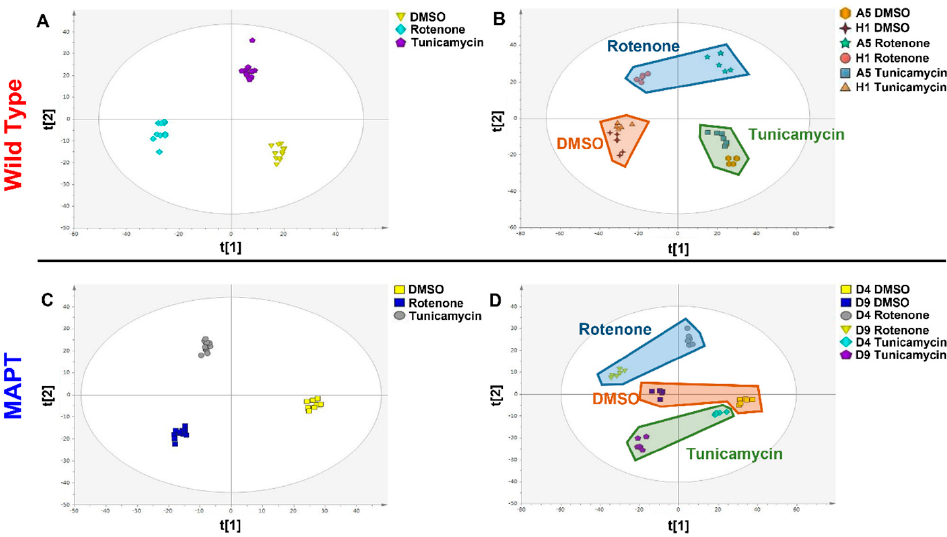
Figure 1. Multivariate partial least squares − discriminant analysis (PLS − DA) of Rotenone and Tunicamycin treatment in wild type and MAPT mutant dopamine neurons. ( A ) PLS-DA scores plot of combined treatment groups in wild type neurons (t[1] = 16.4% and t[2] = 7.7%) ( B ) PLS-DA scores plot of treatment response in individual wild type cell lines (t[1] = 38.3% and t[2] = 15.4%) ( C ) PLS-DA scores plot of combined treatment groups (t[1] = 18.2% and t[2] = 8.9%) ( D ) PLS-DA scores plot of treatment response in individual MAPT cell lines (t[1] = 38.6% and t[2] = 7.9%). Abbreviations: MAPT; microtubule associated protein tau.